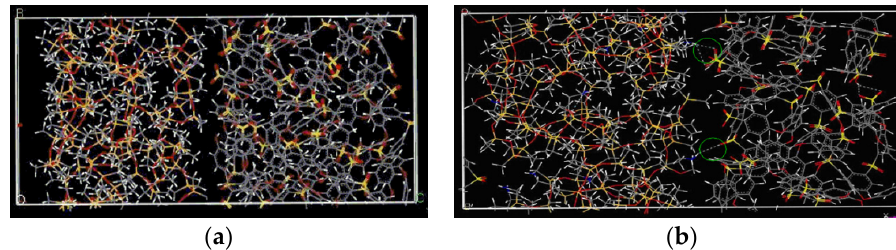
Figure 17. ( a ) The model for the PDMS–TEOS-0.06/PES composite membrane; ( b ) the model for the PDMS–APTMS-0.06/PES composite membrane [78].